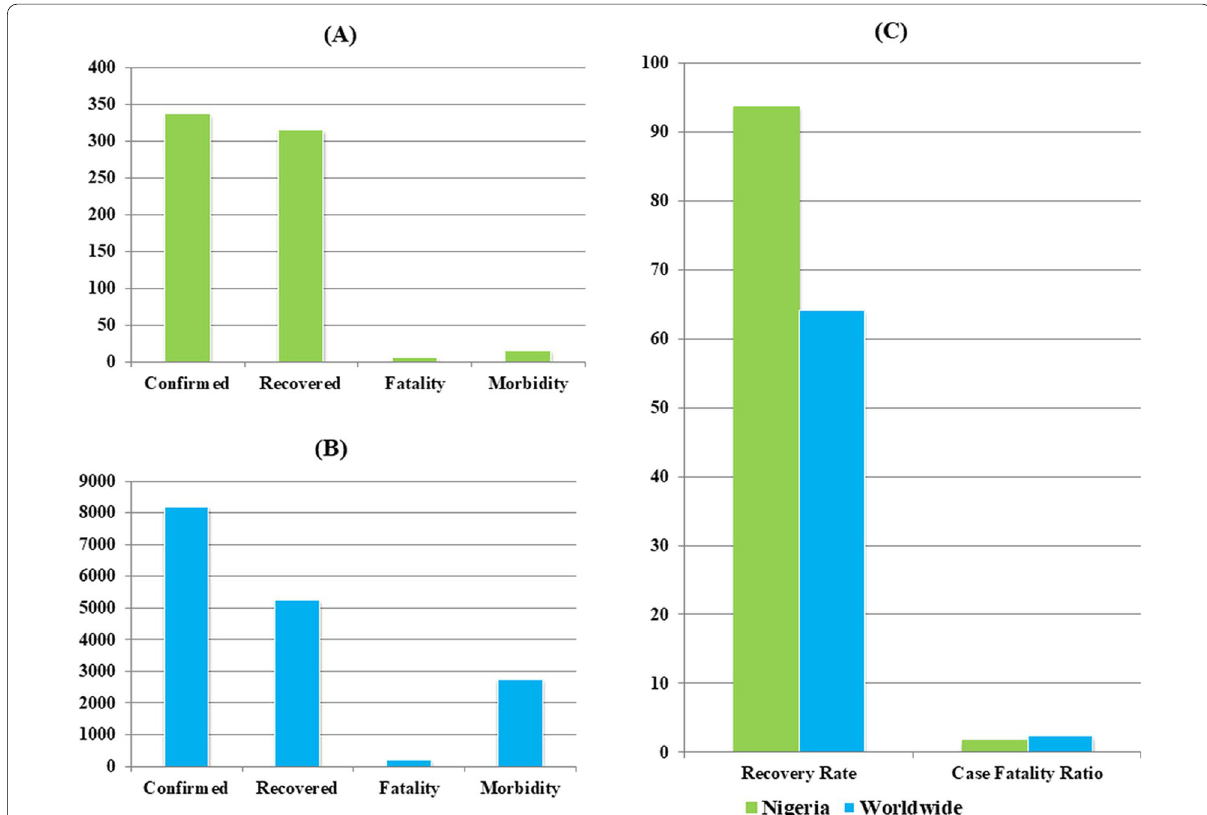
Fig. 2 COVID-19 in Nigeria (NCDC 2020a) and worldwide (Worldometer 2020). ( a ), number of confirmed cases, recovered patients, death and morbidity, per million, in Nigeria, ( b ), number of confirmed cases, recovered patients, death and morbidity, per million, worldwide, ( c ), rate of recoveries and case fatality ratio of COVID-19 world-wide and in